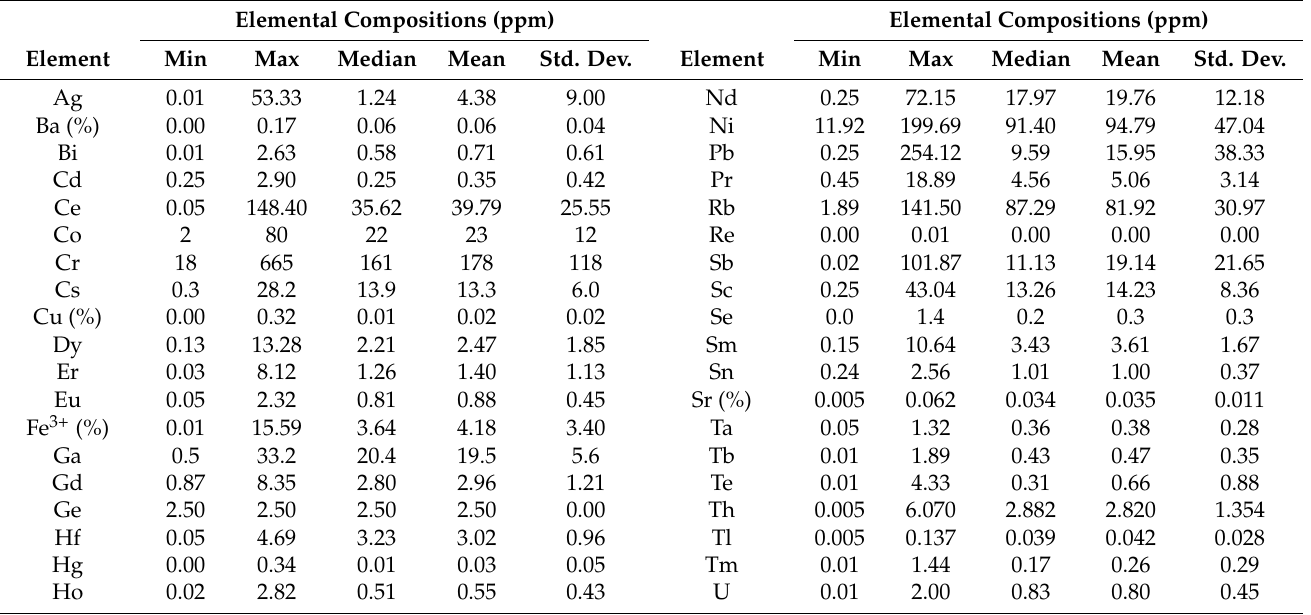
Table A2. Summary of descriptive statistics for minor and trace elemental compositions in 750